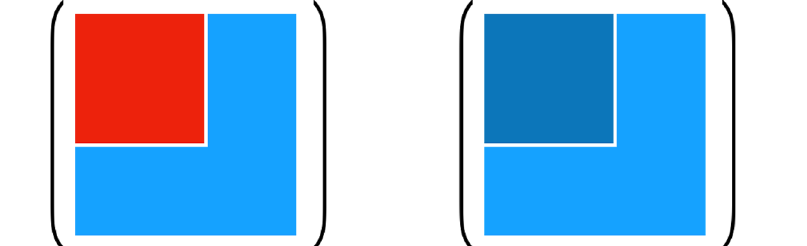
Figure 20. Two different kinds of constrained simulations. [Left] Partially deconfined phase, with the constraint term eq. (4.11). [Right] Completely confined phase, with the constraint term eq.